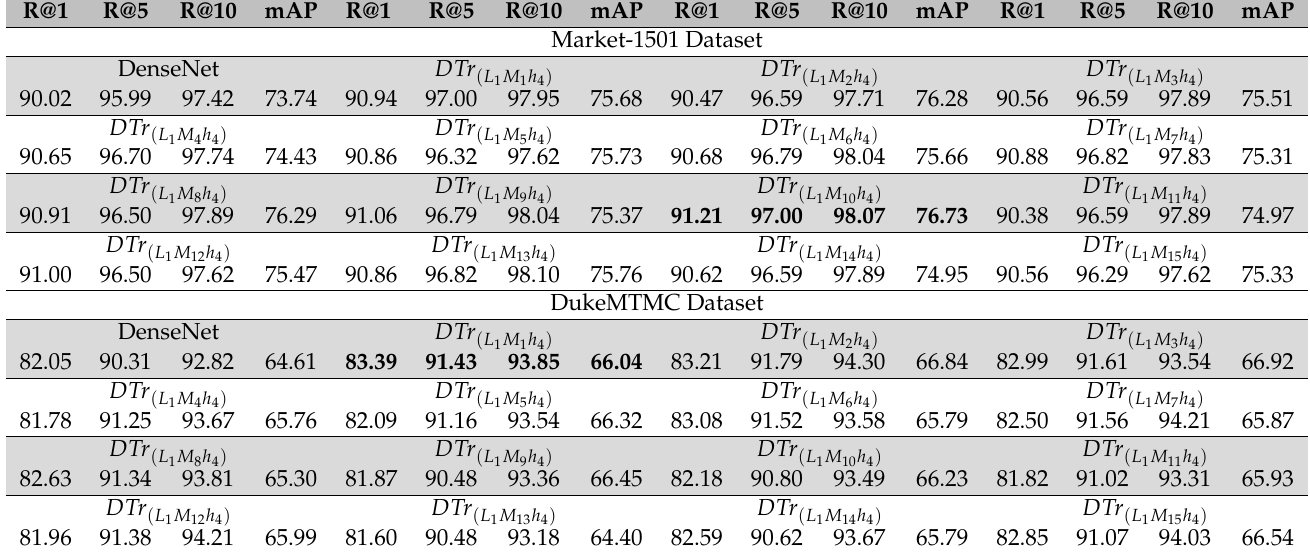
Table 2. The performance of the Dense Transformers (DTr) and baseline (DenseNet121) for Market-1501 [39] and DukeMTMC [40] datasets. The best results are in bold, and “-” represents that the network did not converge in the given number of epochs. The subscripts of “L”, “M” and “h” represent the presence of transformers after that block, the number of transformers after each block, and the number of heads in the model,